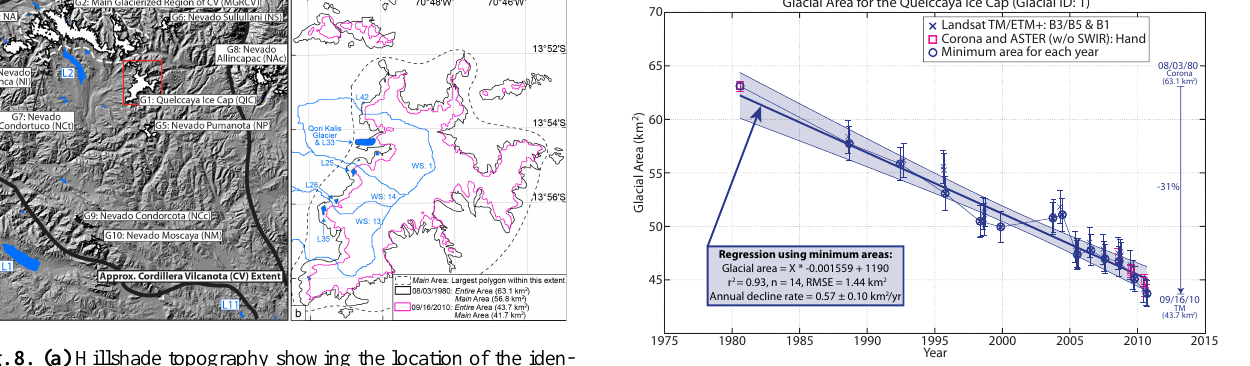
Fig. 9. Glacial-area time series for the Quelccaya Ice Cap (Glacial ID 1, Fig. 8). Symbols indicate image type and classification method. Bold and circled data points indicate the minimum area for that year (in some cases, the only area for that year). The regres- sion uses only these minimum areas, and shading around regression outlines 95% confidence interval (same as uncertainties for the an- nual decline rates). Error bars are 1 σ uncertainties. Time series for each Glacial ID can be found in the Supplement (Figs.